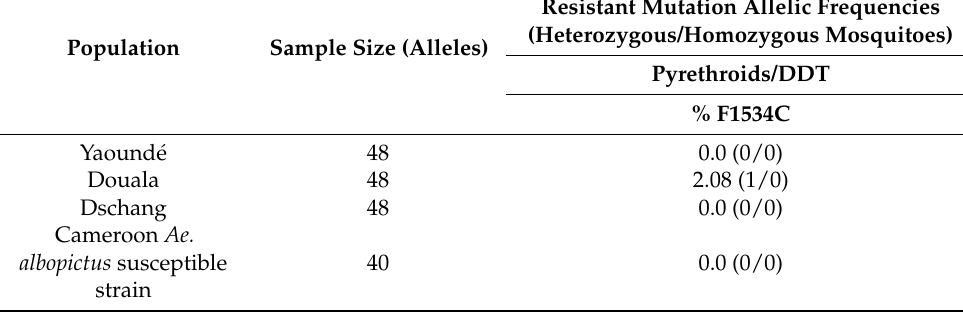
Table 3. Incidence of resistance alleles in different populations of Ae. albopictus mosquitoes, assayed by TaqMan qPCR.